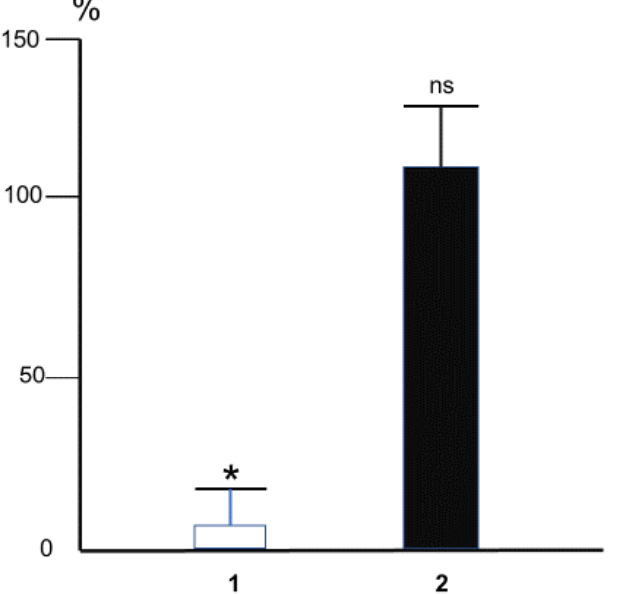
Figure 7. The effect of intra-arterial MDA (10 mM, 60 s) on changes of the hydraulic conductance of rat iliac artery (measured as the ratio of blood flow in the artery to the pressure drop on it) caused by overall triple step-like increase of blood flow (1) or acetylcholine (10 − 6 M) (2). The magnitude of change of arterial conductance at control conditions was taken for 100%. Bars correspond to the mean magnitudes of the dilator reactions rated in percentage to initial ones in each experiment. * p < 0.01, ns—not significant. n = 5 (Methods of the experiments were described in detail in [45]).